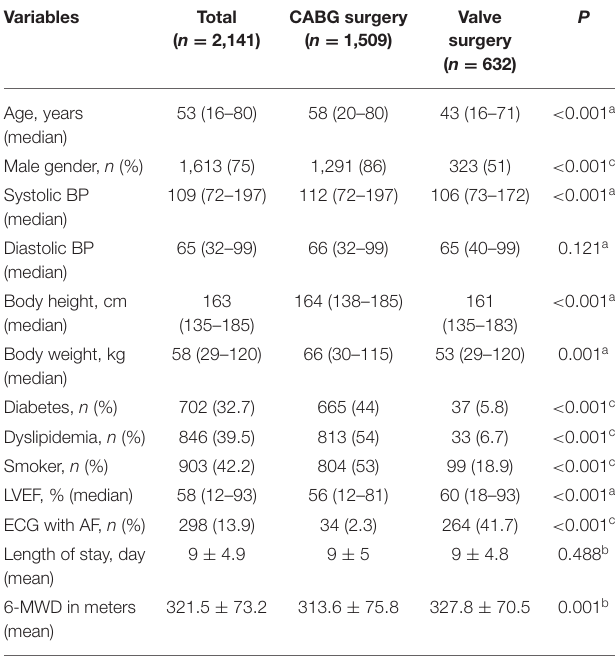
TABLE 1 | Baseline characteristic of patients after cardiac